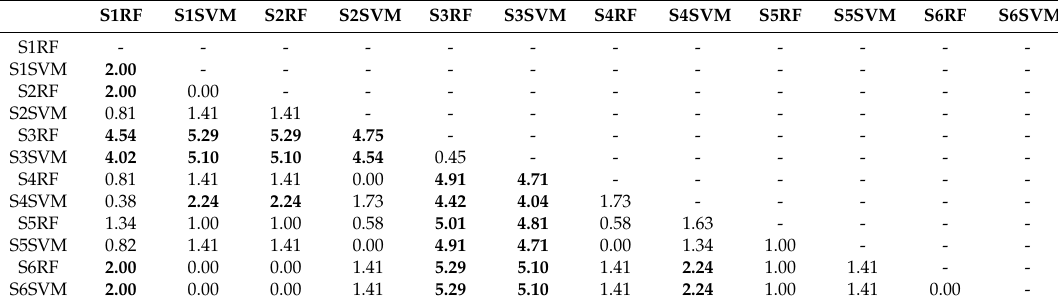
Table 6. Summary of McNemar test results (|z|-values) of binary classifications for site A. The best classification for scheme 1 was used. |Z|-values are in bold if significantly different using α = 0.05.